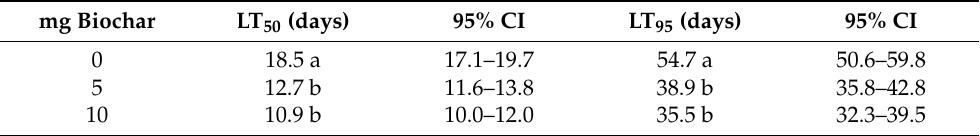
Table 1. Lethal time (LT) estimates to 50% (LT 50 ) and 95% (LT 95 ) mortality (maximum likelihood) with 95% confidence intervals (CI) for O. pseudotsugata larvae reared on synthetic diet with dry biochar material applied to the surface. Within a column, estimates of LT followed by the same letter are not significantly